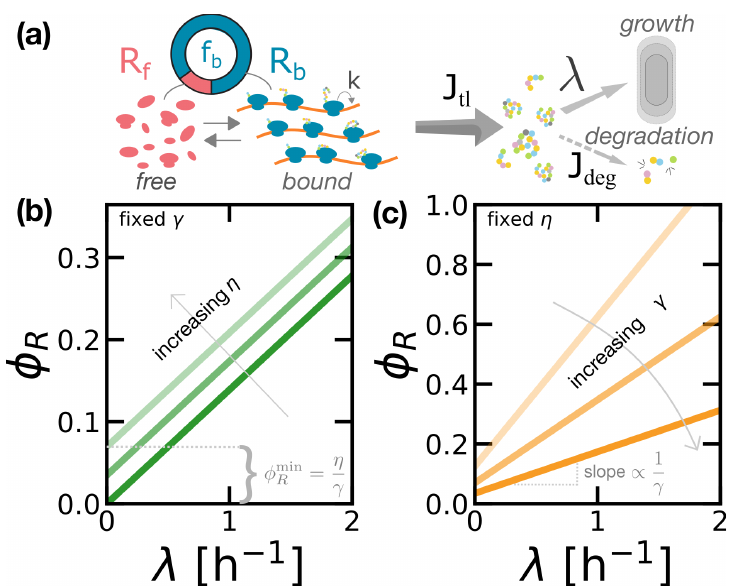
Fig 3. Protein degradation determines an offset in the first growth law. (a) Sketch of the first model of protein production proposed in this work, which includes protein degradation but no inactive ribosomes. In this model, ribosomes follow a first-order kinetics to bind the transcripts, and all bound ribosomes contribute to protein synthesis (mass production). Proteins can be lost by protein degradation or diluted by cell growth. (b) The law ϕ R ( λ ) predicted ¼ Z = g . The offset increases linearly with degradation rate η at a constant ribosome by Eq (6) shows an offset � min R production rate γ . (c) Varying γ also changes � min but it also affects the slope of ϕ R ( λ ). Panel (b) reports ϕ R ( λ ) for γ = R 7.2 h − 1 and η = 0, 0.25, 0.5 h − 1 . Panel (c) fixes η = 0.25 h − 1 and varies γ = 2, 3.6, 7.2 h − 1 .